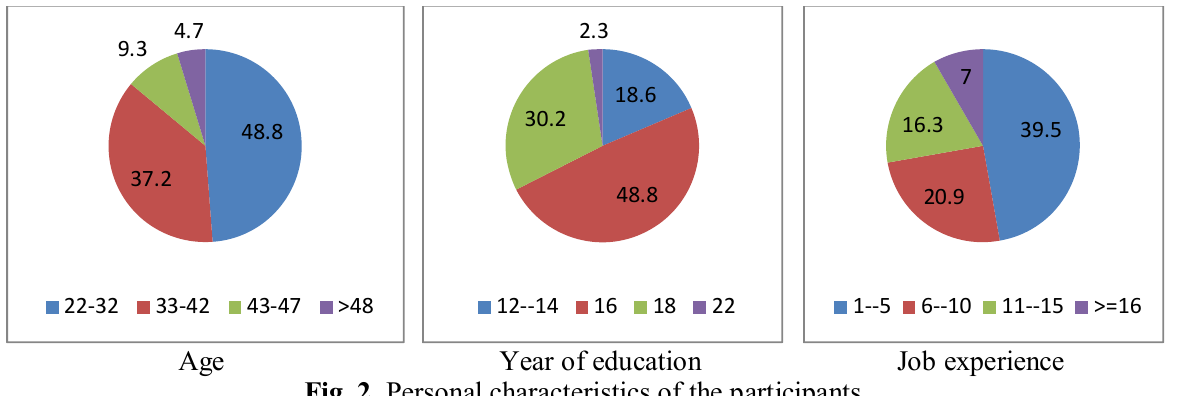
Fig. 2. Personal characteristics of the participants